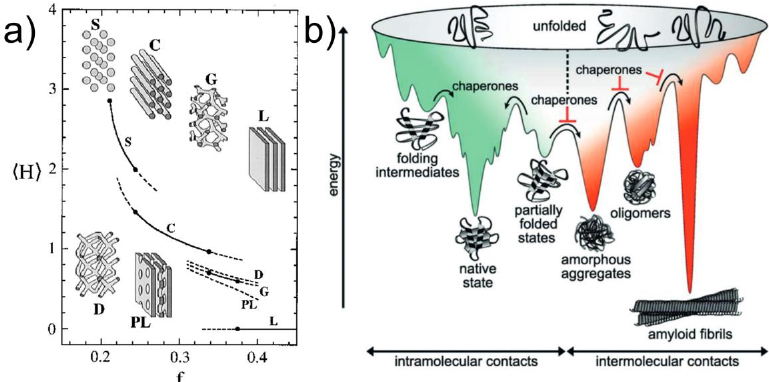
Figure 1. ( a ) Schematic of a diblock copolymer curvature phase diagram. The average mean curvature, <H> dictates the equilibrium phase as it compensates for the entropic loss due to chain stretching between the blocks at asymmetric volume fractions, f << 0.5 [19] . ( b ) Energy landscape of protein folding highlighting the myriad of metastable states accessible [23] . Adapted with permission from references [19,23] .